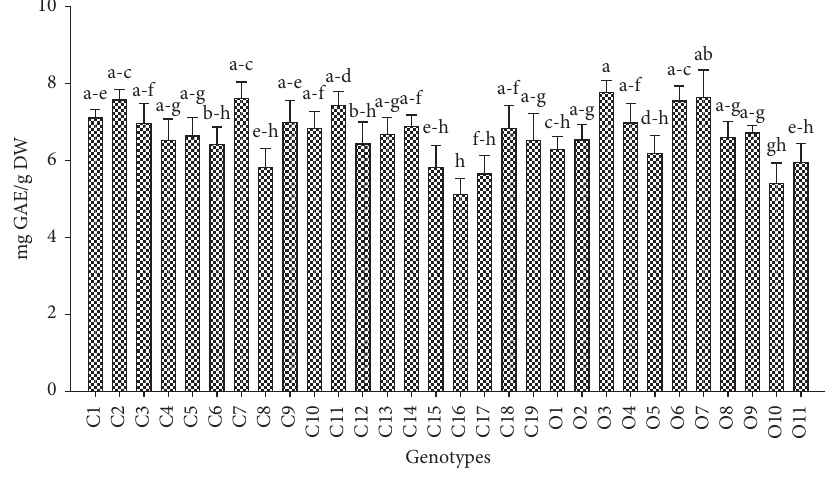
Figure 2: Variation in the content of total